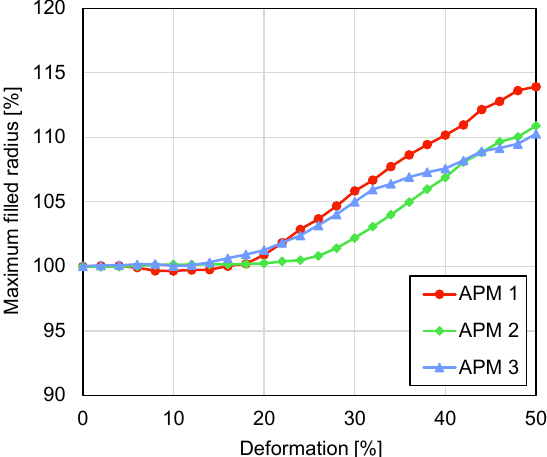
Figure 12. Maximum filled radius plotted against deformation.